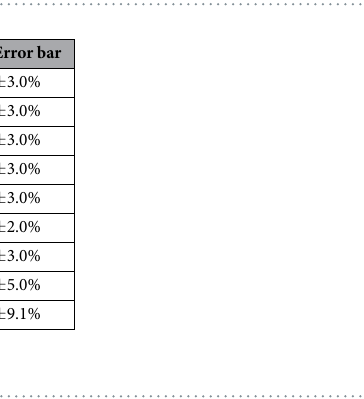
Figure 4. ( a , b ) PL spectra of a single QD in a micropillar with a diameter of 2 μ m before ( a ) and after ( b ) fabrication under non-resonant, 780 nm pulsed excitation. ( c ) PL spectrum of the QD in micropillar under 858 nm pulsed excitation. ( d ) Detected fluorescent counts of the same QD as a function of the normalized pulse laser power P P / under 780 nm (black) and 858 nm (red) pulsed excitation, here P and P represent to the sat sat excitation and saturation power. The inset shows a spectrum after a longpass filter and a narrow band filter with a bandwidth of 1 nm. ( e , f ) Intensity-correlation histogram obtained using a Hanbury Brown and Twiss-type set-up under 780 nm ( e ) and 858 nm ( f ) pulsed excitation. The value of g (0) 2 is calculated from the integrated photon counts in the zero time delay peaks divided by the average of the adjacent four peaks, and its error denotes one standard deviation. The fitting function for each peak is the convolution of a double exponential decay (exciton decay response) with a Gaussian (single-photon detector time response) 19 . Owing to the limited time response, the small two peaks around the zero time have finite overlaps.